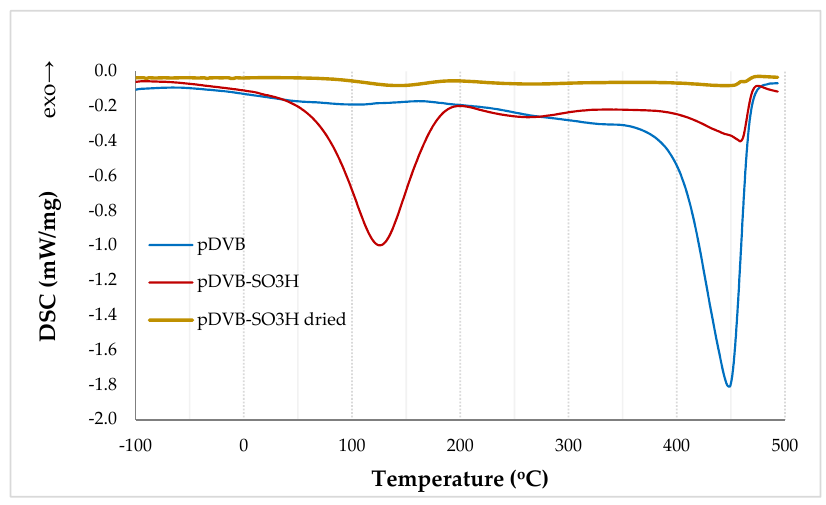
Figure 2. The DSC results for pDVB and pDVB-SO 3 H polymers.